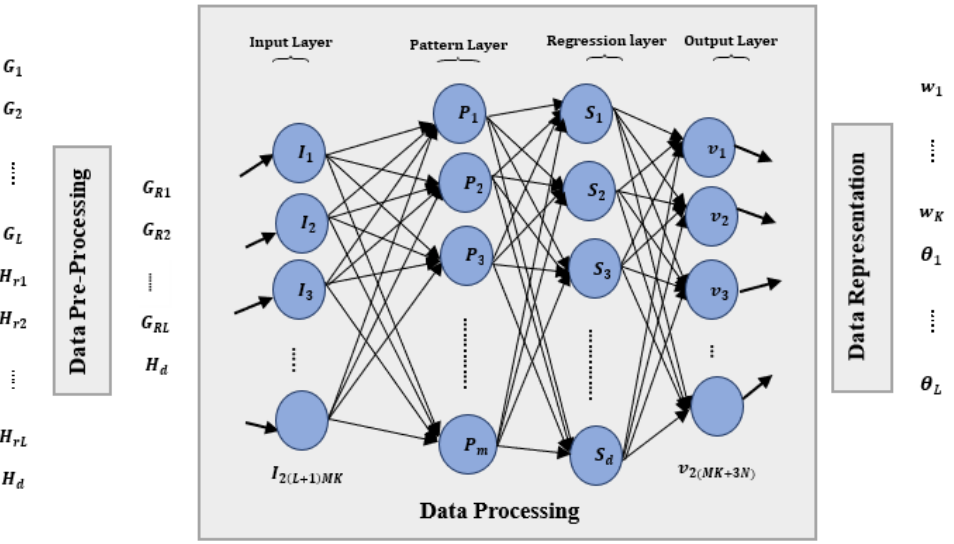
Figure 2. The designed GRNN structure, where θ l = diag ( Θ l ) denotes N phase shifts of the l -th